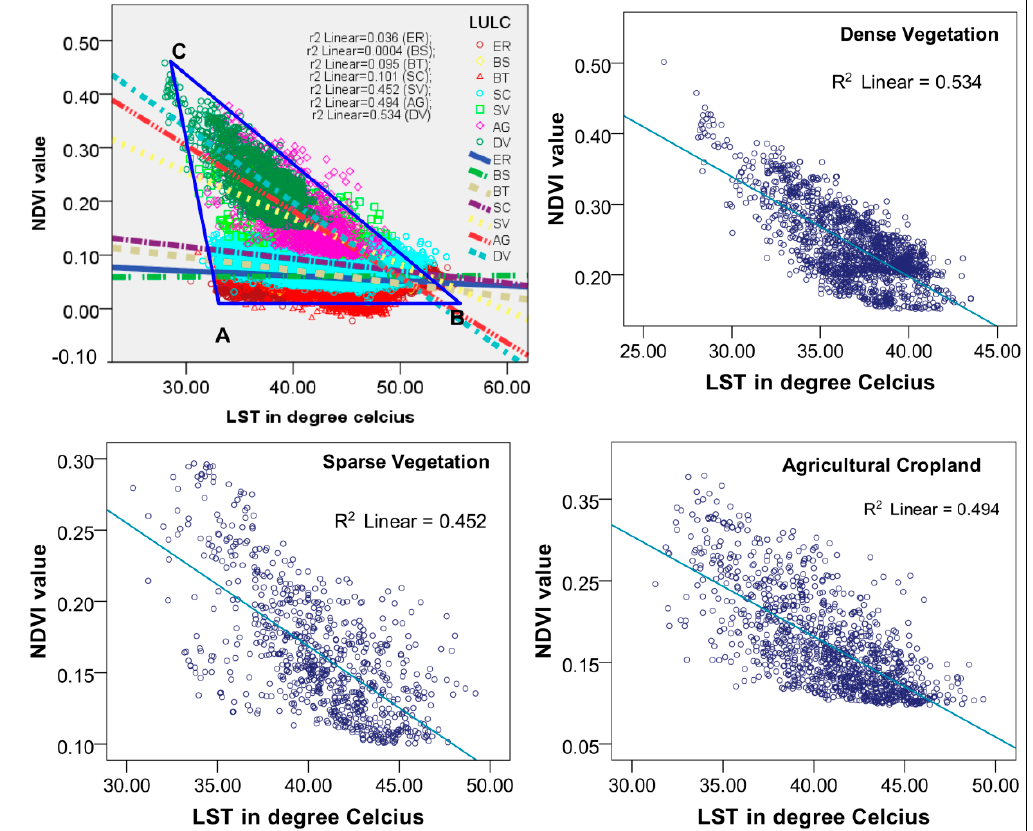
Figure 6. Linear regression coefficient between LST and NDVI for LULC class as a whole, dense vegetation, agricultural land, and sparse vegetation.